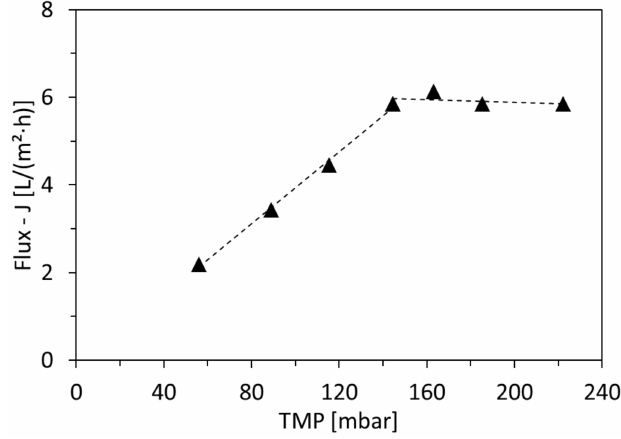
Figure 3. Critical-flux and critical-TMP determination for 5 nm pore size